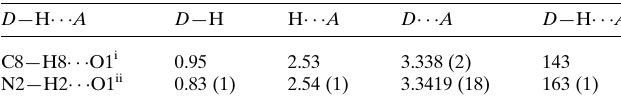
Table 1 Hydrogen-bond geometry (A˚ , (cid:3) ).